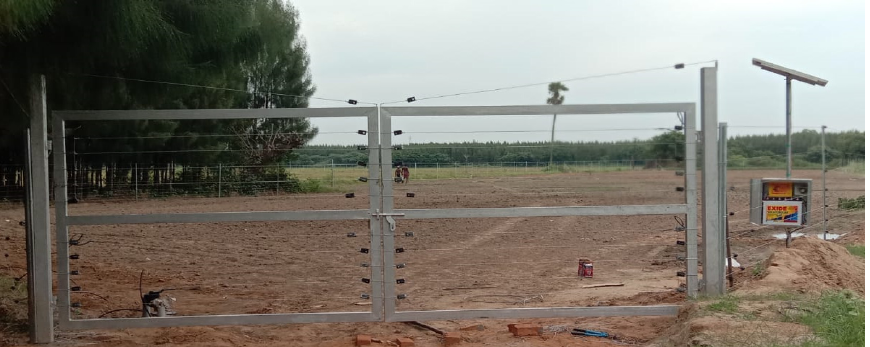
Figure 5. Solar fencing for agricultural field.